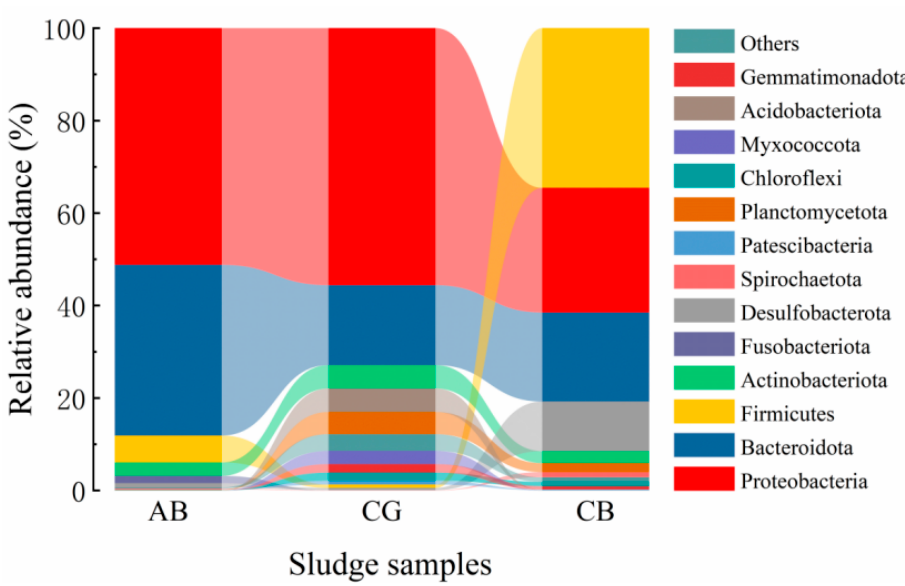
Figure 5. Microbial communities at phylum level (relative abundance over 1%).